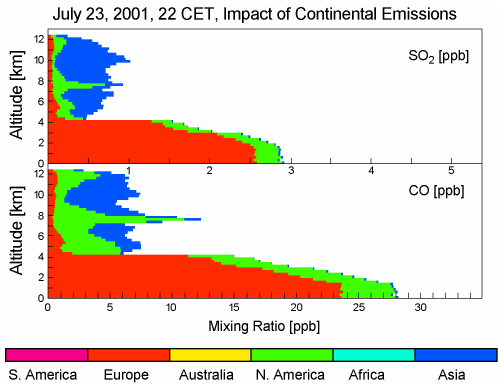
Fig. 18. Vertical distribution of FLEXPART SO 2 and CO emission tracers from the different source continents simulated for the lidar measurement on 23 July 1999, 22:00CET (twenty-day